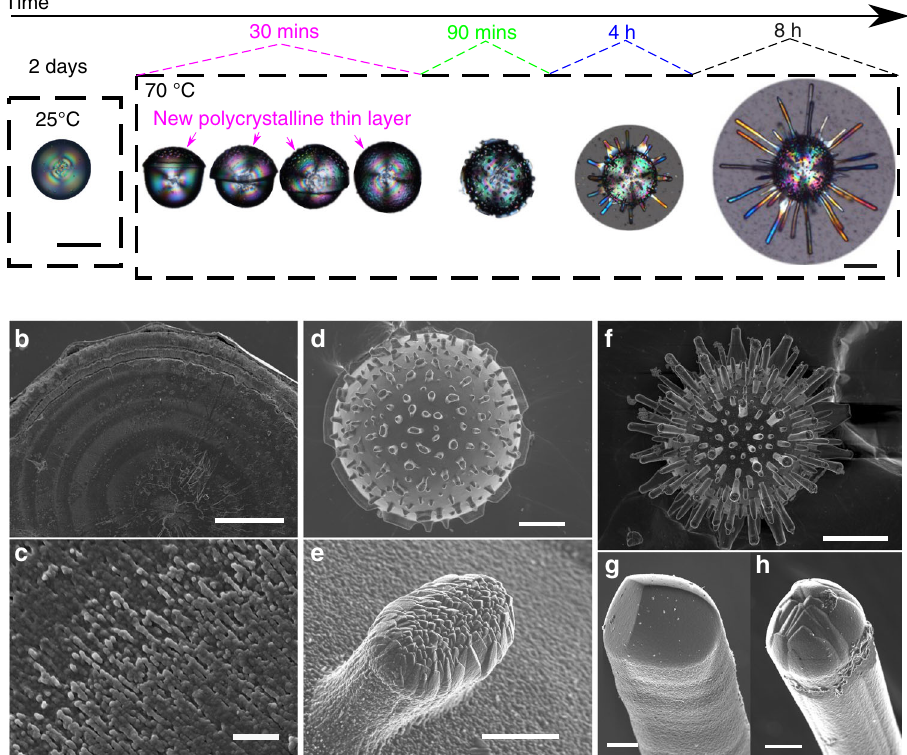
Fig. 3 Growth process of a sea urchin-like MHC architecture. a Optical micrographs showing the evolution of morphology during the growth process of MHC under the stepwise modulation of temperature (25 and 70 °C); b – h selected FESEM images of MHC particles and corresponding textures formed at different stages: spherulites at 25 °C ( b , c ), early stage of sea urchin-like particle ( d ) and the developing faceted stick ( e ) at 70 °C, and fi nal shape of sea urchin-like particle ( f ) and the faceted sticks ( g , h ) at 70 °C. Scale bars: 50 μ m ( b , d ), 1 μ m ( c ), 100 μ m ( a , f ), 5 μ m ( e , g , h